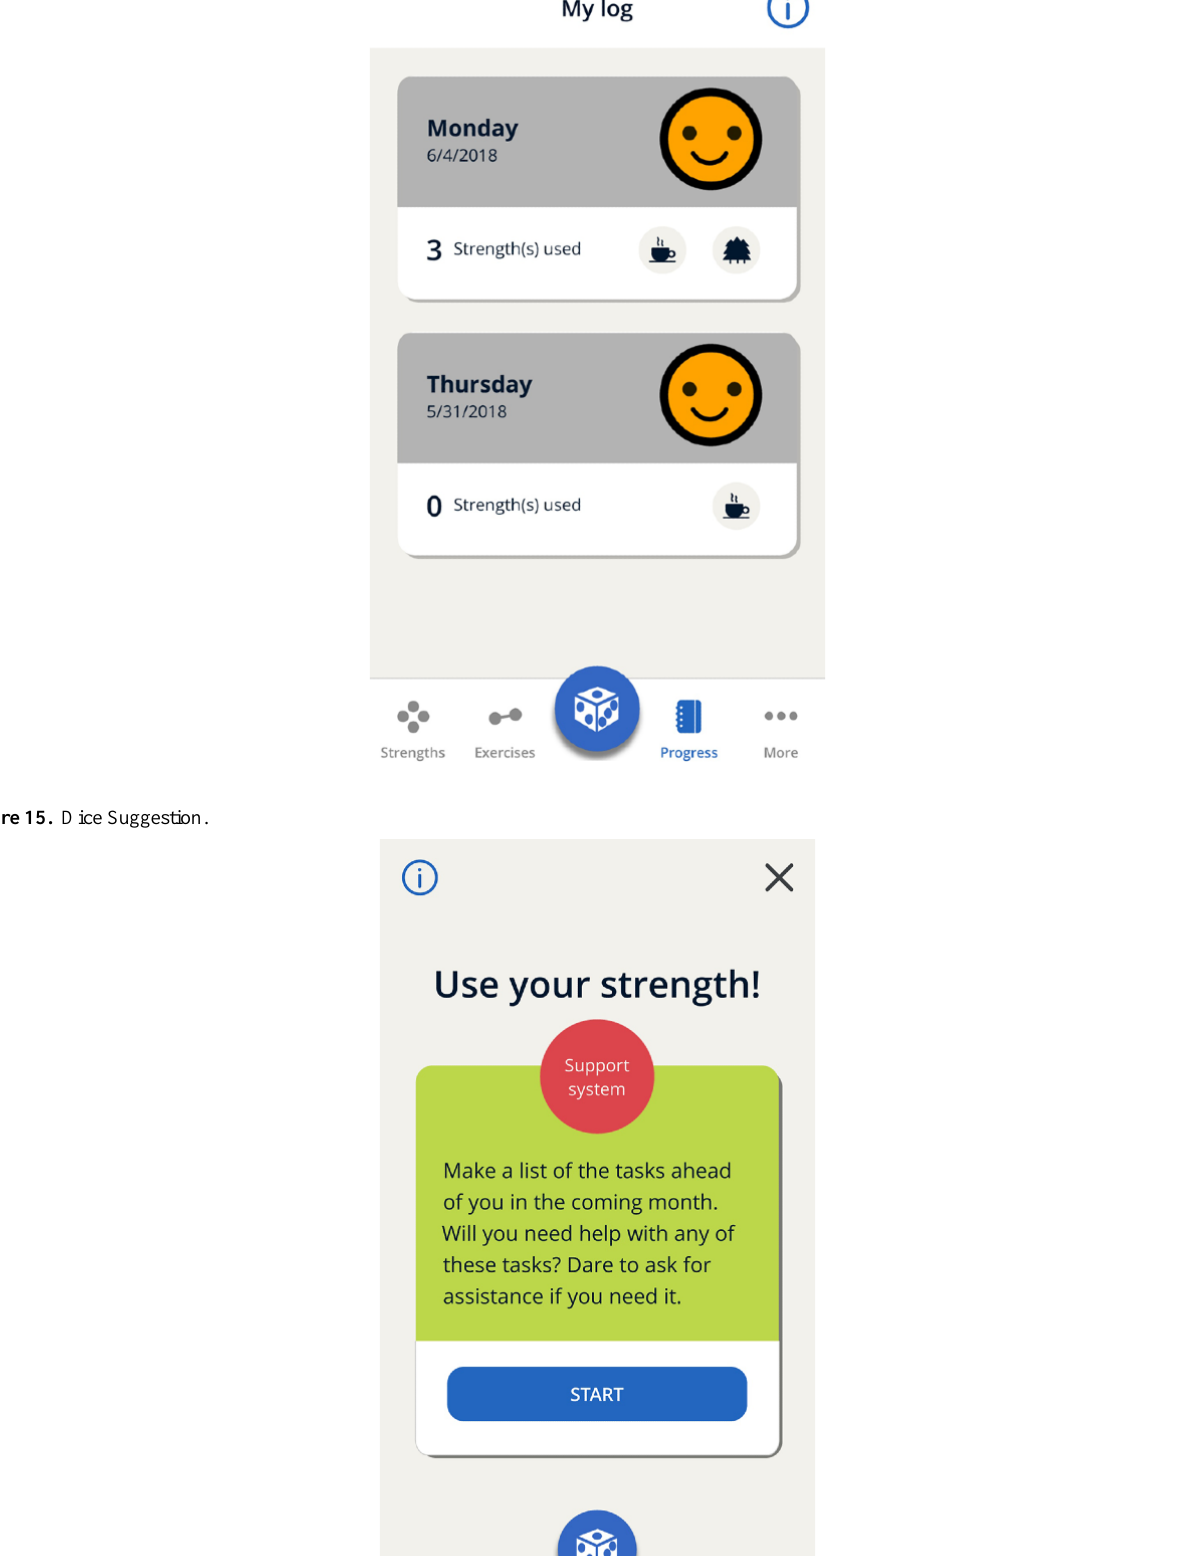
Figure 14. Daily Log.